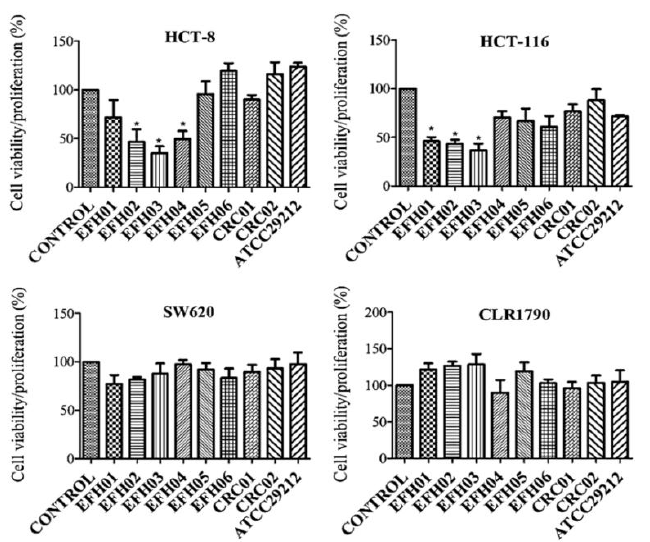
Figure 2. Estimated differences in the cell viability/proliferation index for each experimental group with respect to the control, one net of variability between the experiments after 72 h of exposure to E. faecalis metabolites. Error bars indicate the standard deviation (* p ≤ 0.05). HCT-8: Human ileocecal adenocarcinoma cell line; HCT-116: Human colon carcinoma cell line; SW-620: human colorectal adenocarcinoma cell line; CLR-1790: normal human diploid cell line